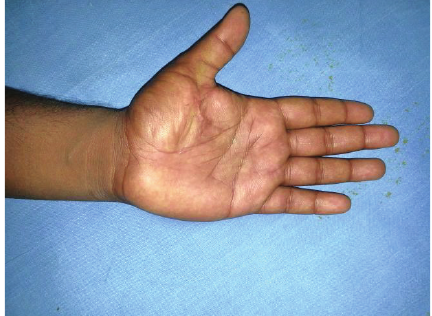
Figure 3: Flexor digitorum superficialis tendon repaired to the flexor pollicis tendon.